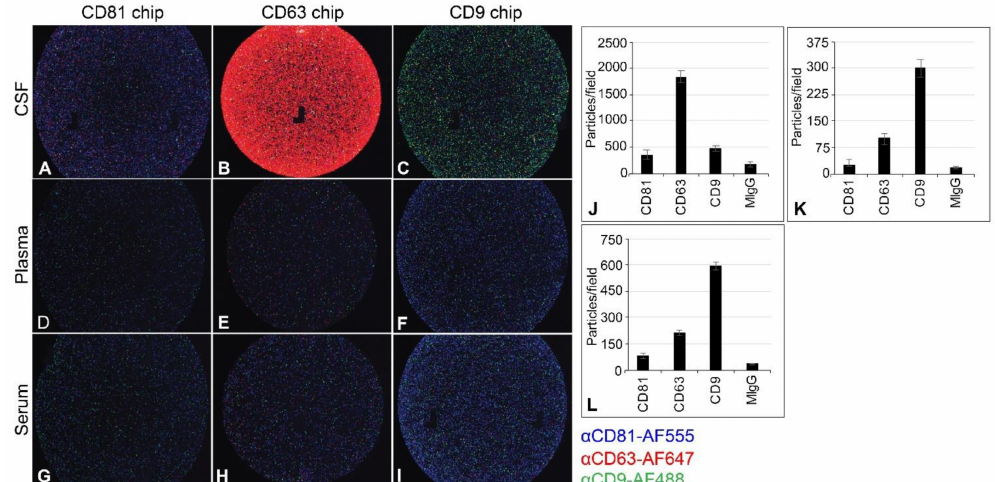
Figure 5. Exoview analysis of tetraspanin presentation on EV derived from CSF, plasma, and serum. Unlabeled EV were captured on CD9, CD63, or CD81 antibody chips. Bound EV were stained with α CD9-AF488 (green), α CD81-AF555 (blue), and α CD63-AF647 (red) ( A – I ). The intensity of each fluorescent antibody signal reflects the relative abundance of each tetraspanin. CD63 is the predominant EV marker in CSF ( B , J ). CD9 is the predominant EV marker in plasma ( F , K ) and serum ( I , L ). Average particle counts per 150- µ M field of view for each captured tetraspanin before staining are shown for CSF ( J ), plasma ( K ), and serum ( L ). As expected, there are differences in tetraspanin expression between sample types. Error bars represent standard deviation. CSF = cerebrospinal fluid; EV = extracellular vesicles; MIgG = mouse immunoglobulin